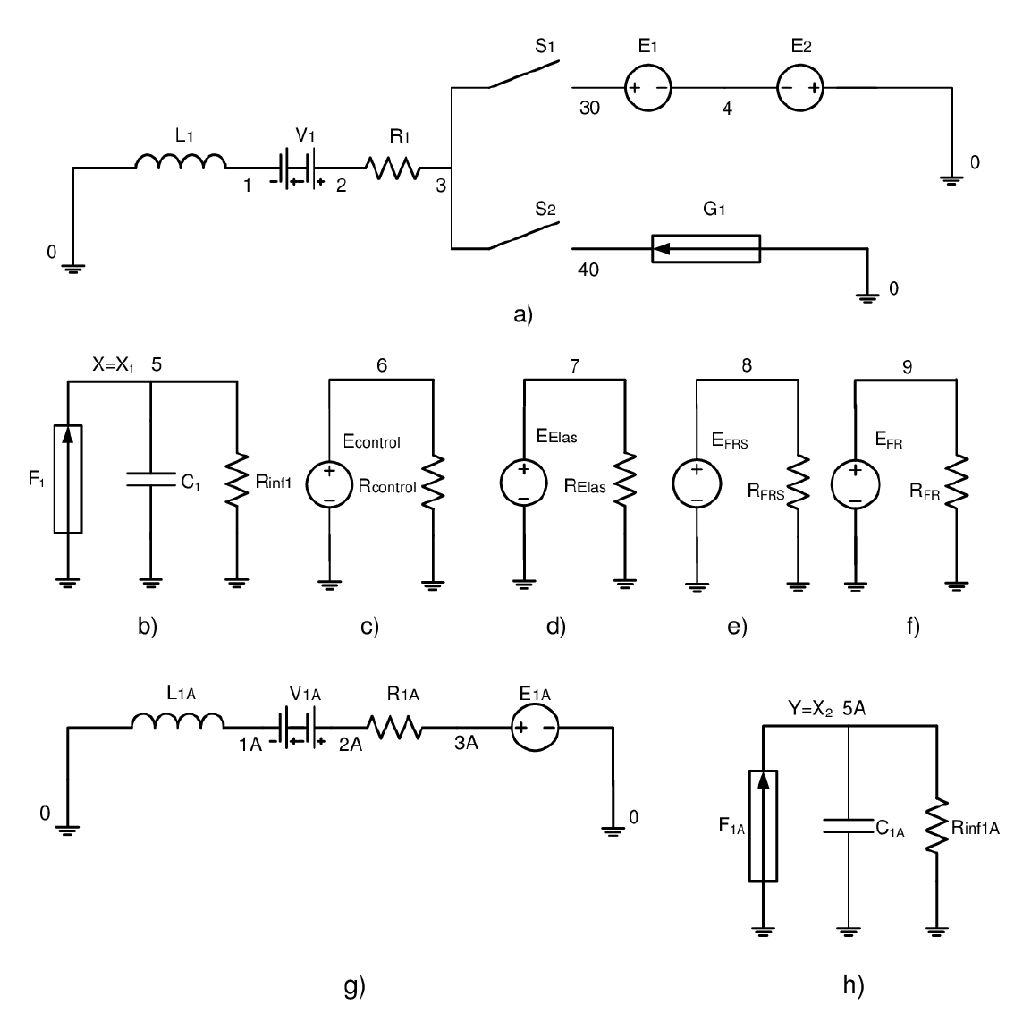
Figure 6 Network model. a) and g) Main circuits, b) and h) auxiliary circuits to get x and y, c) auxiliary circuit which control switches, d) auxiliary circuit which controls the transition between stick and slip phases, and e) and f)